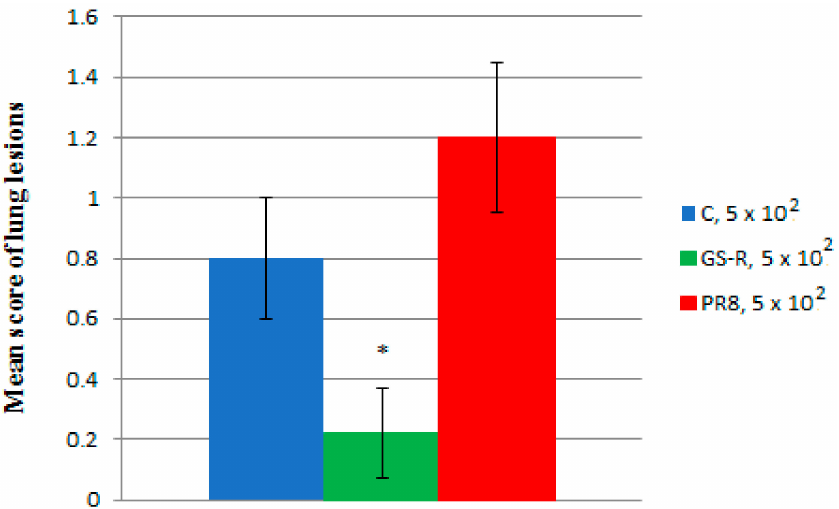
Figure 10. Development of post-influenza lesions in lungs of mice infected with three influenza viruses. Animals were inoculated with influenza viruses (5 × 10 2 TCID 50 per mouse), and their lungs were studied after 10 days for signs of post-influenza lesions. PR8: initial egg-derived virus, C: virus after ten passages in MDCK cells; GS-R: virus after ten passages in MDCK cells in the presence of ginsamide, * represents p <